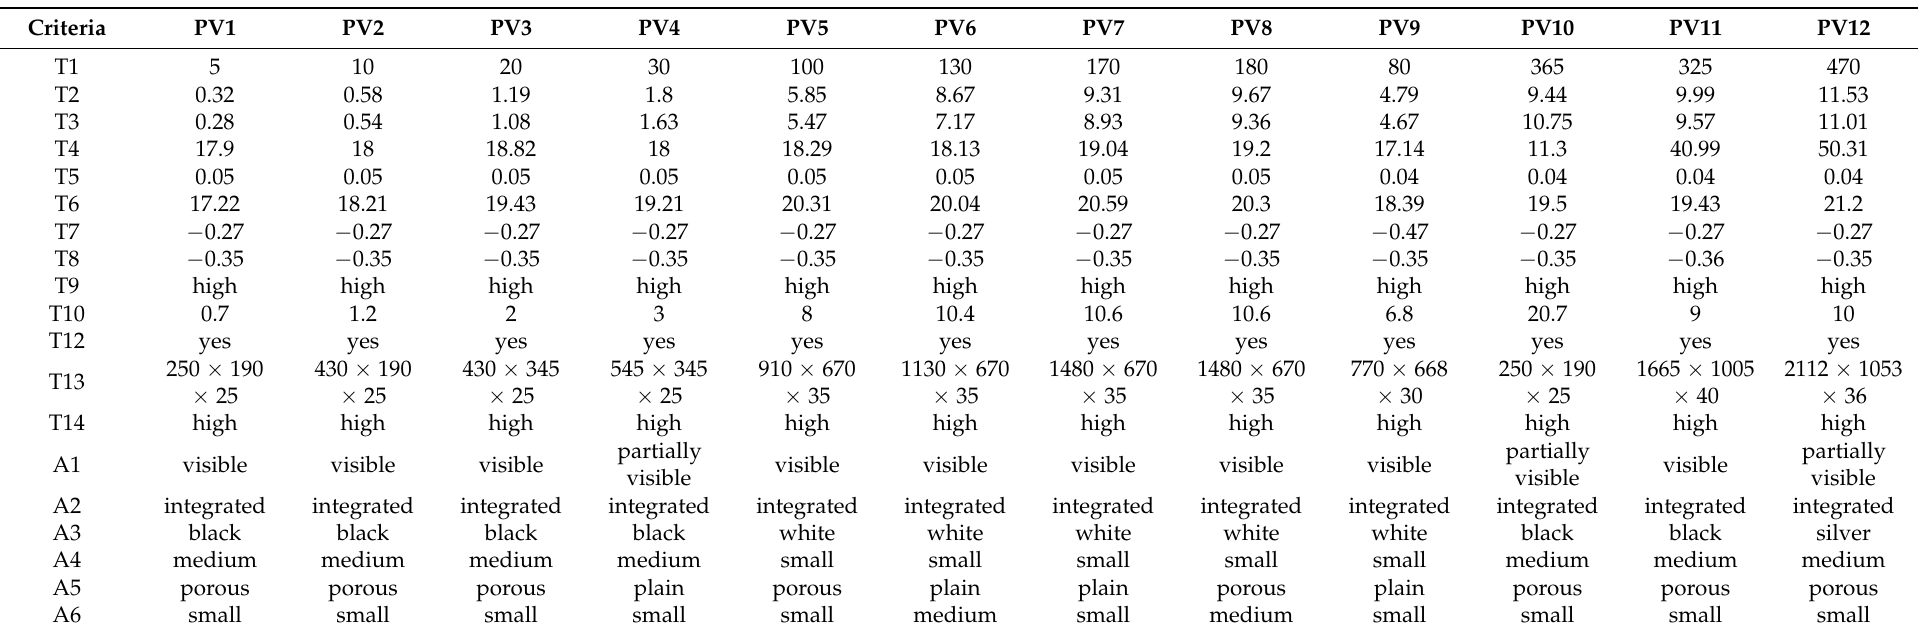
Table 14. Characteristic of selected photovoltaic panels according to key criteria. Own